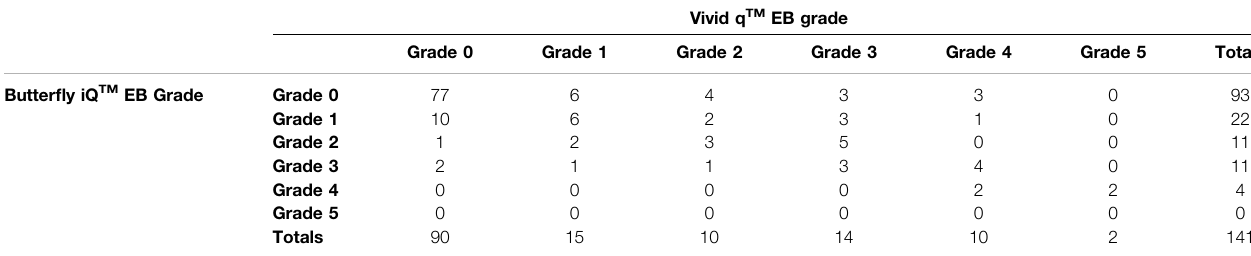
TABLE3| ContingencytableshowingEftedal-Brubakk(EB)gradeagreementbetweentheVividq ™ andButter fl yiQ ™ .TheweightedkappaagreementbetweenEBgrades derived from the Butter fl y iQ ™ and the Vivid q ™ measurements was found to be 0.52 ± 0.06.